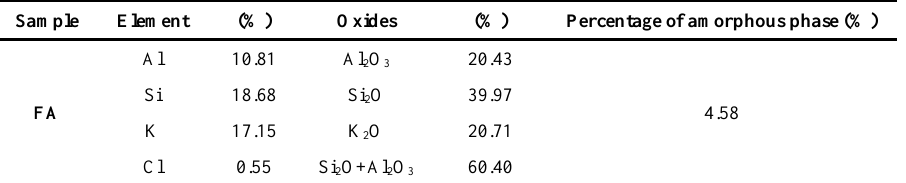
Table 3. Amorphous phase content of silica fly.